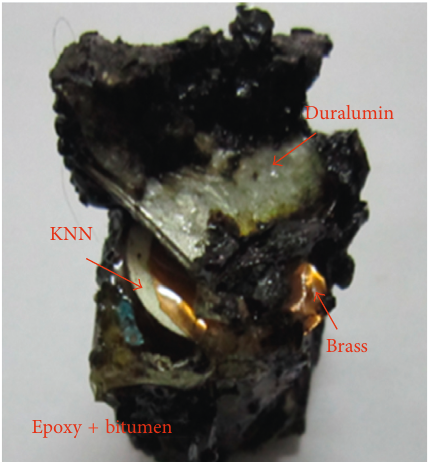
Figure 1: Sample of the KNN-bitumen stacked